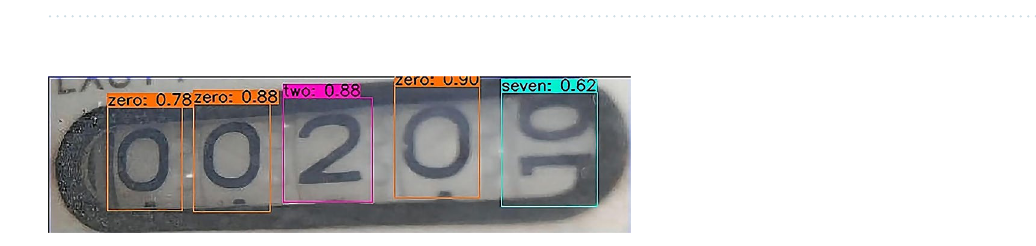
Figure 14. A partial rendering of the Faster RCNN test.